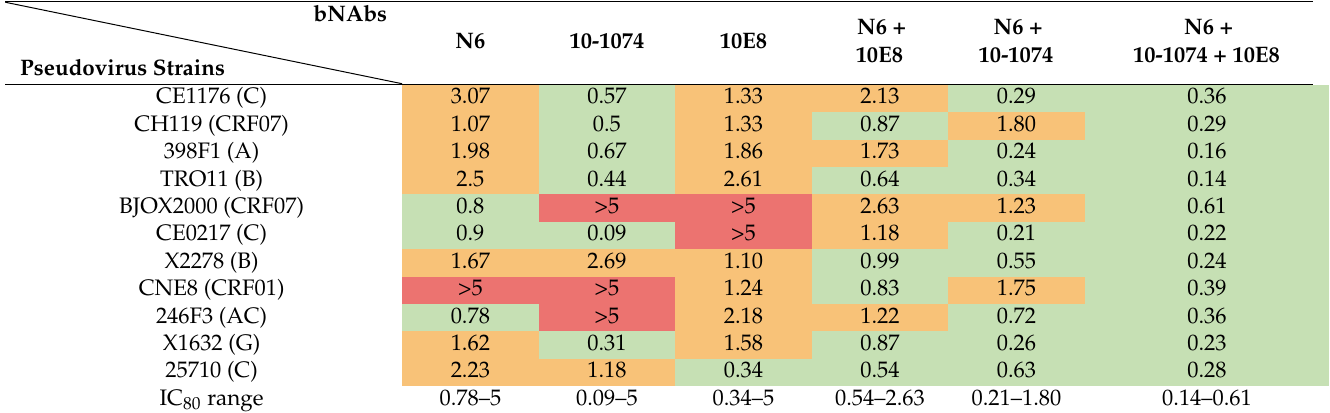
Pseudovirus Strains